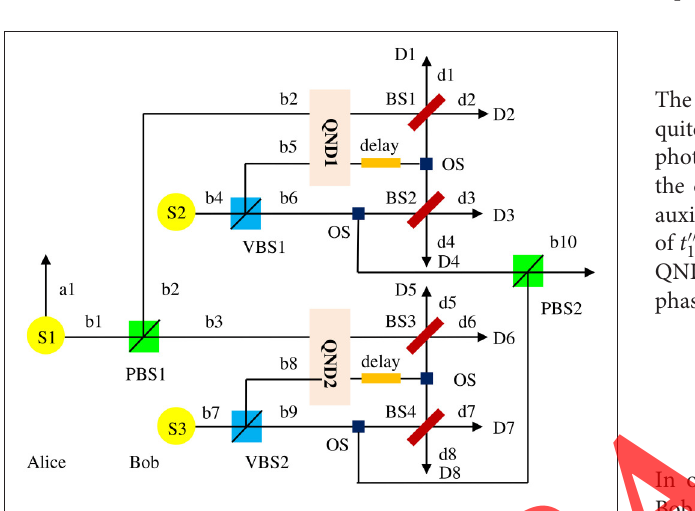
FIGURE 3 | A schematic drawing of our second ECP with the QND constructed by the cross-Kerr nonlinearities. The QND can make a parity check of the photon state without destroying the photons. The optical switch (OS) will cause the photon to pass through different spatial modes. With the help of the QND and OS, the second ECP can be repeated to further concentrate the discarded items of the first ECP. The delay line is used to precisely control the time of the photon arriving at the